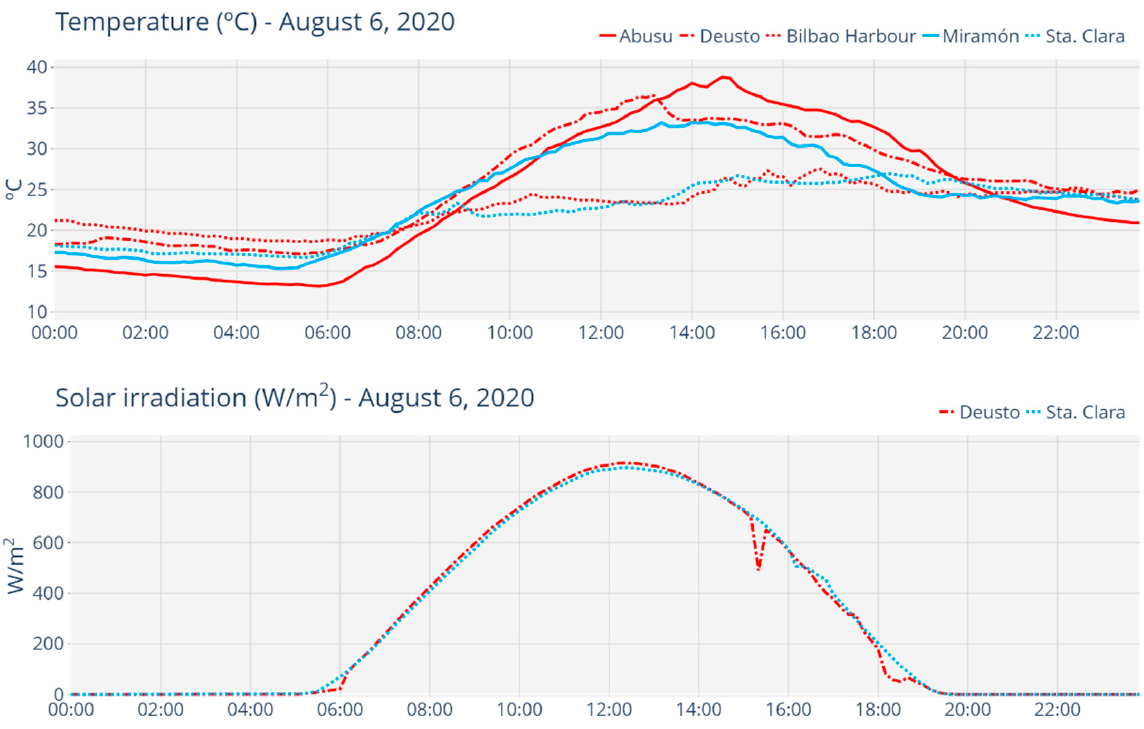
Figure 13. Comparison between recorded temperatures ( top ) and solar radiation ( bottom ) on a clear day in summer (6 August 2020). Source: authors.